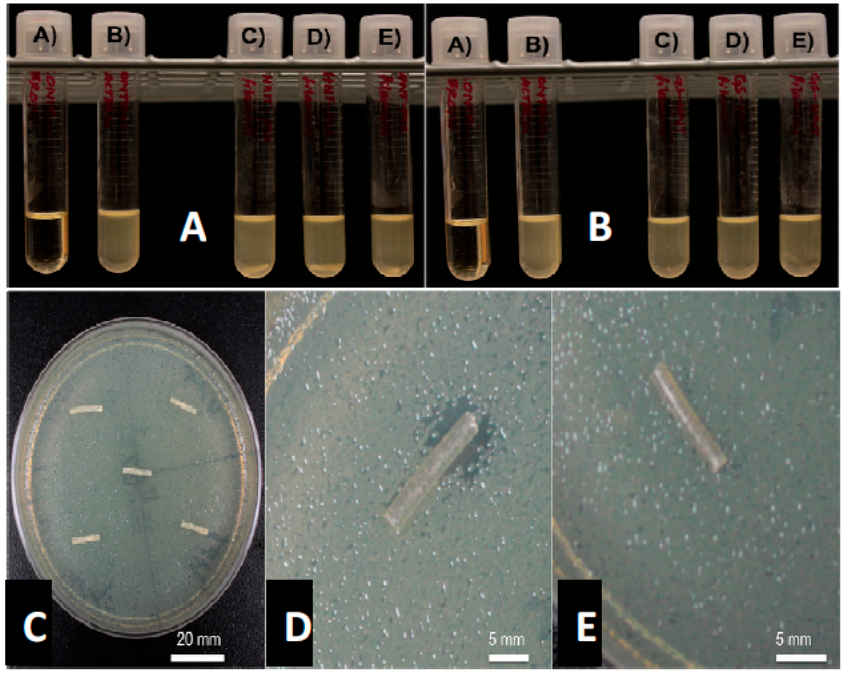
Figure 4. ( A ): (A) Sterile broth; (B) E. coli inoculated broth; (C–E) 10 wt % HNT doped PLA filaments. ( B ): (A) Sterile broth; (B) E. coli inoculated broth; (C–E) 1.5 wt % gentamicin loaded HNT doped PLA filaments. ( C ): 10 wt % HNT-PLA filament; ( D , E ): 1.5 wt % HNT loaded with gentamicin PLA filament.